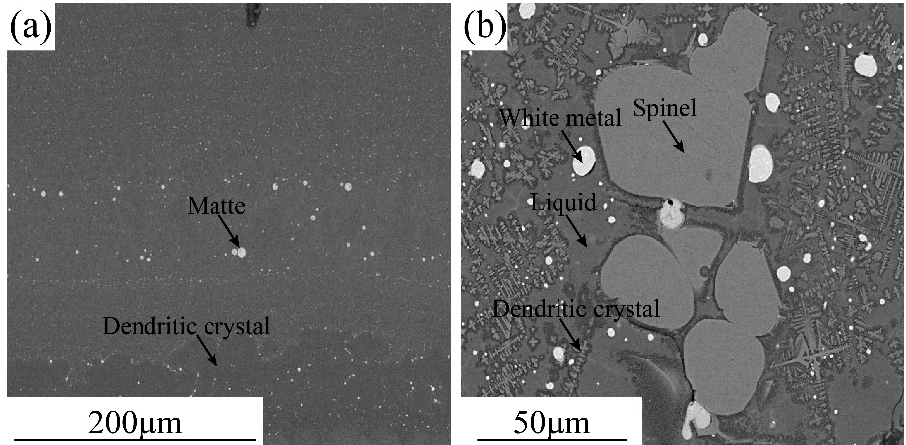
Figure 1. Typical microstructures of the quenched smelting and converting slags: ( a ) Smelting slag and ( b ) Converting slag.